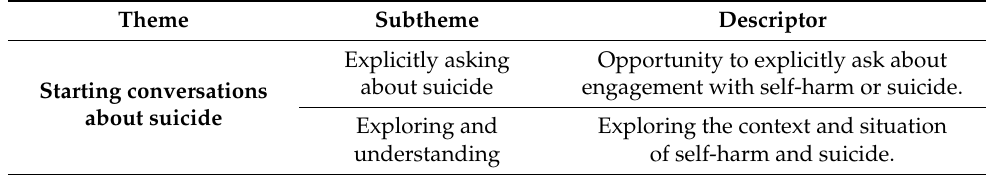
Table 1. Overview of thematic framework and